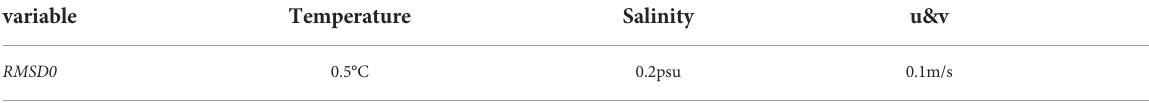
TABLE 1 The surface RMSD of each variable de fi ned in the 3DVAR.